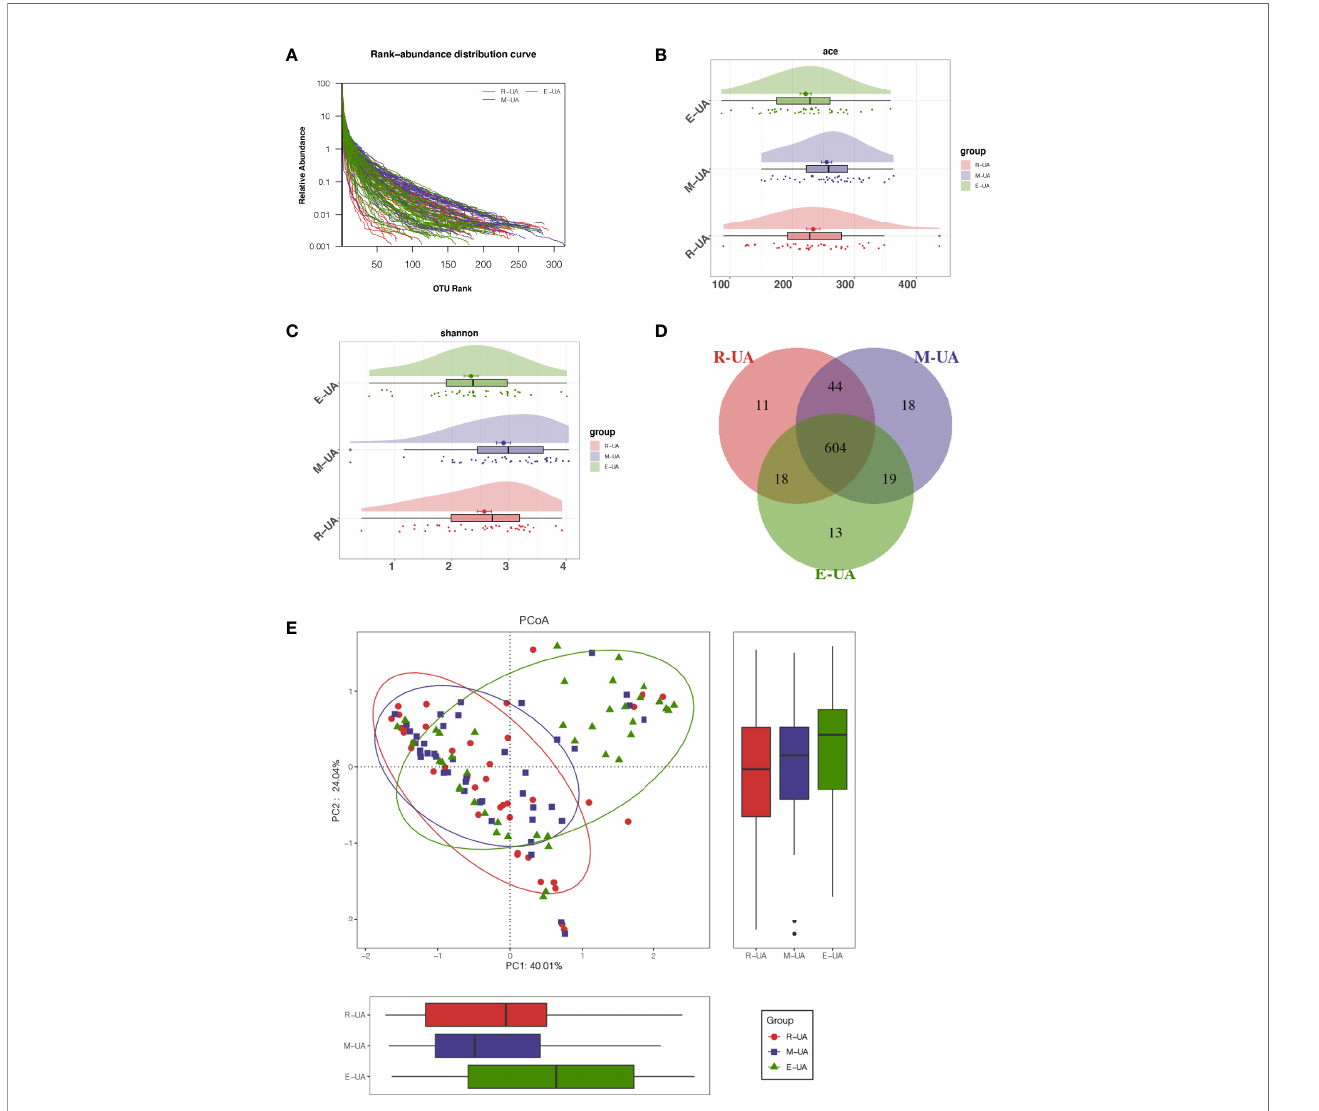
FIGURE 3 | Decreased bacterial diversity in E_UA. (A) Rank-abundance curves indicated that the amount of sequencing data is reasonable. Bacterial richness and diversity (including richness and evenness) were assessed by Ace index (p = 0.028; B ) and Shannon index (p = 0.003; C ). (D) Venn diagram showed that there were 13 unique operational taxonomic units (OTUs) in E_UA group and 604 shared OTUs among the three groups. (E) Beta diversity visualized the dissimilarity of microbial community among samples using principal coordinates analysis (PCoA) based on unweighted UniFrac algorithum. E_UA, elevated uric